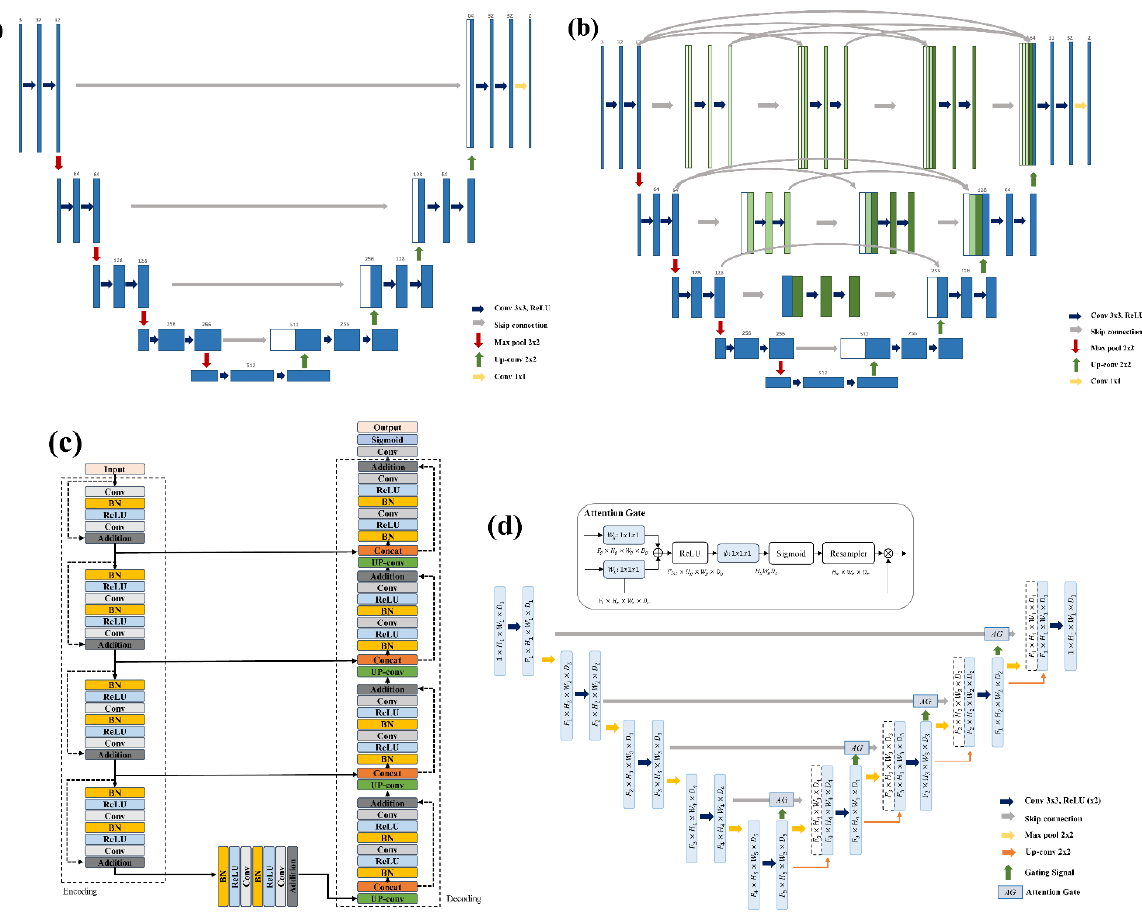
Figure 2. Architecture of each model, ( a ) Basic U-Net, ( b ) U-Net++, ( c ) Residual U-Net, and ( d ) Attention U-Net.